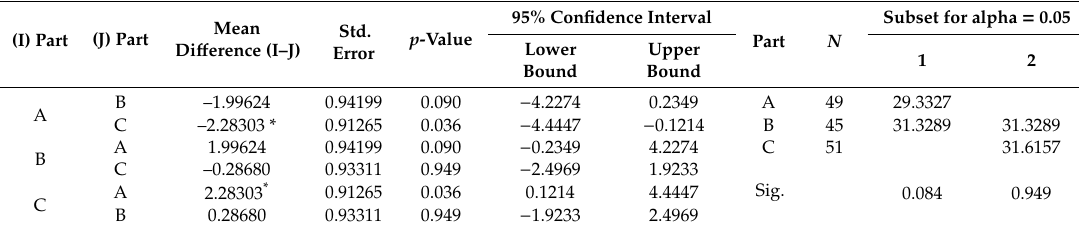
Table 8. Tukey PET analyses in the three investigated intersections (A, B and C).